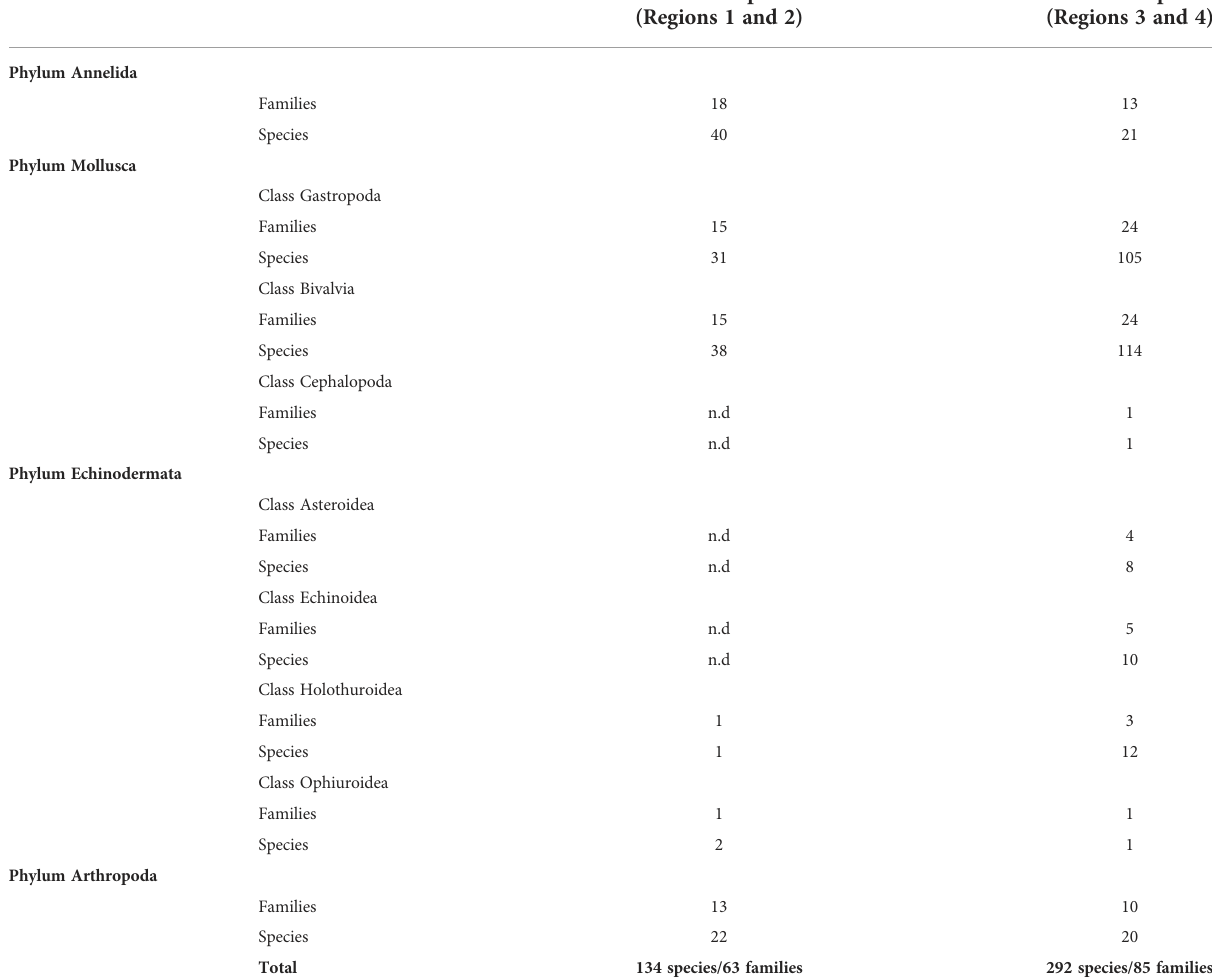
TABLE 3 Number of family and species of zoobenthos in seagrass